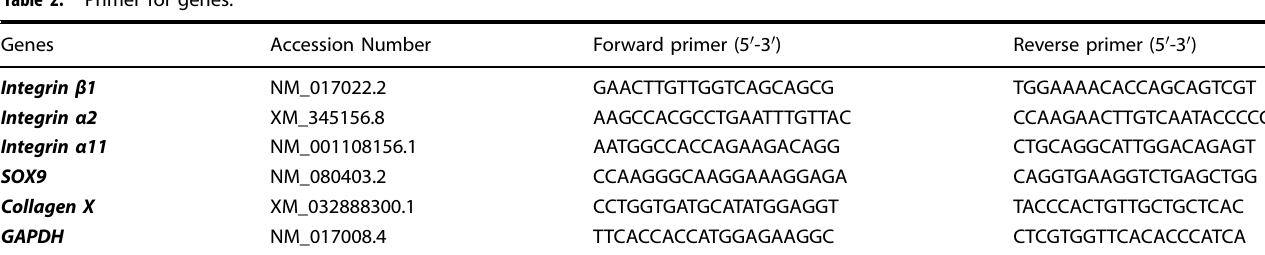
Table 2. Primer for